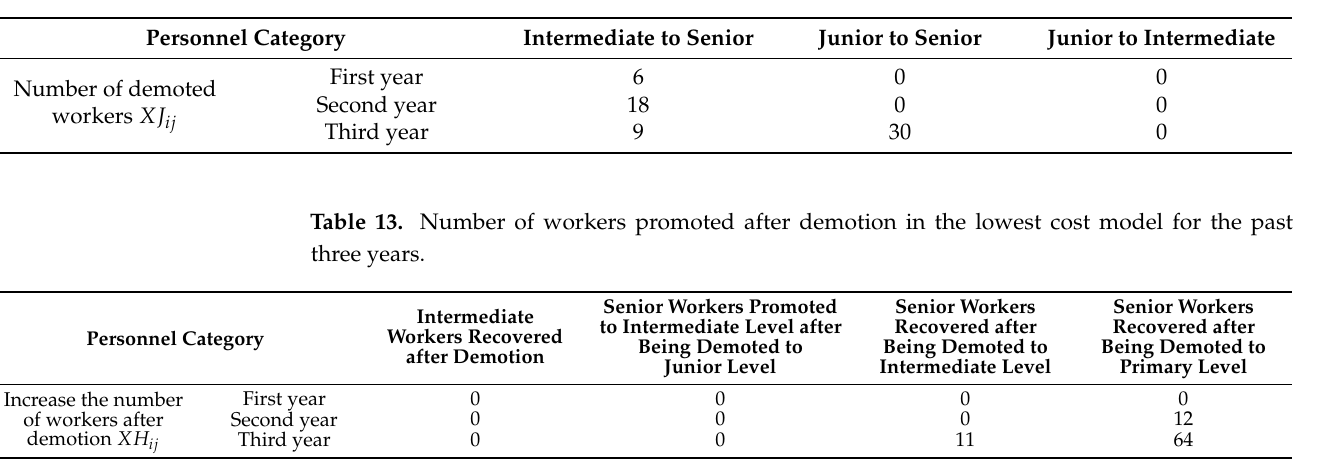
Table 12. Number of demoted workers in the lowest cost model for the past three years.